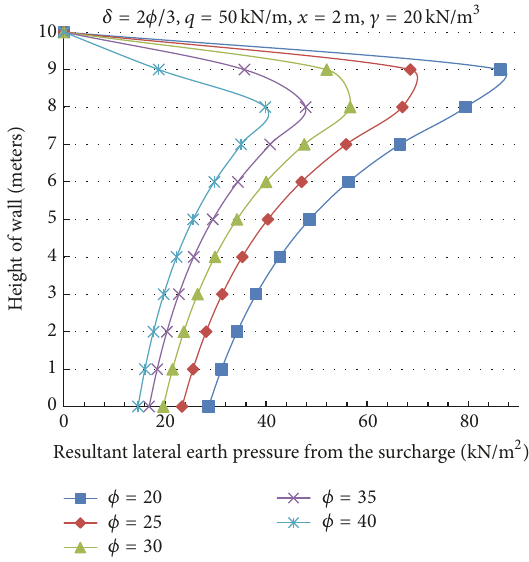
Figure 10: Resultant lateral earth pressure from the surcharge for different values of the angle of internal friction.